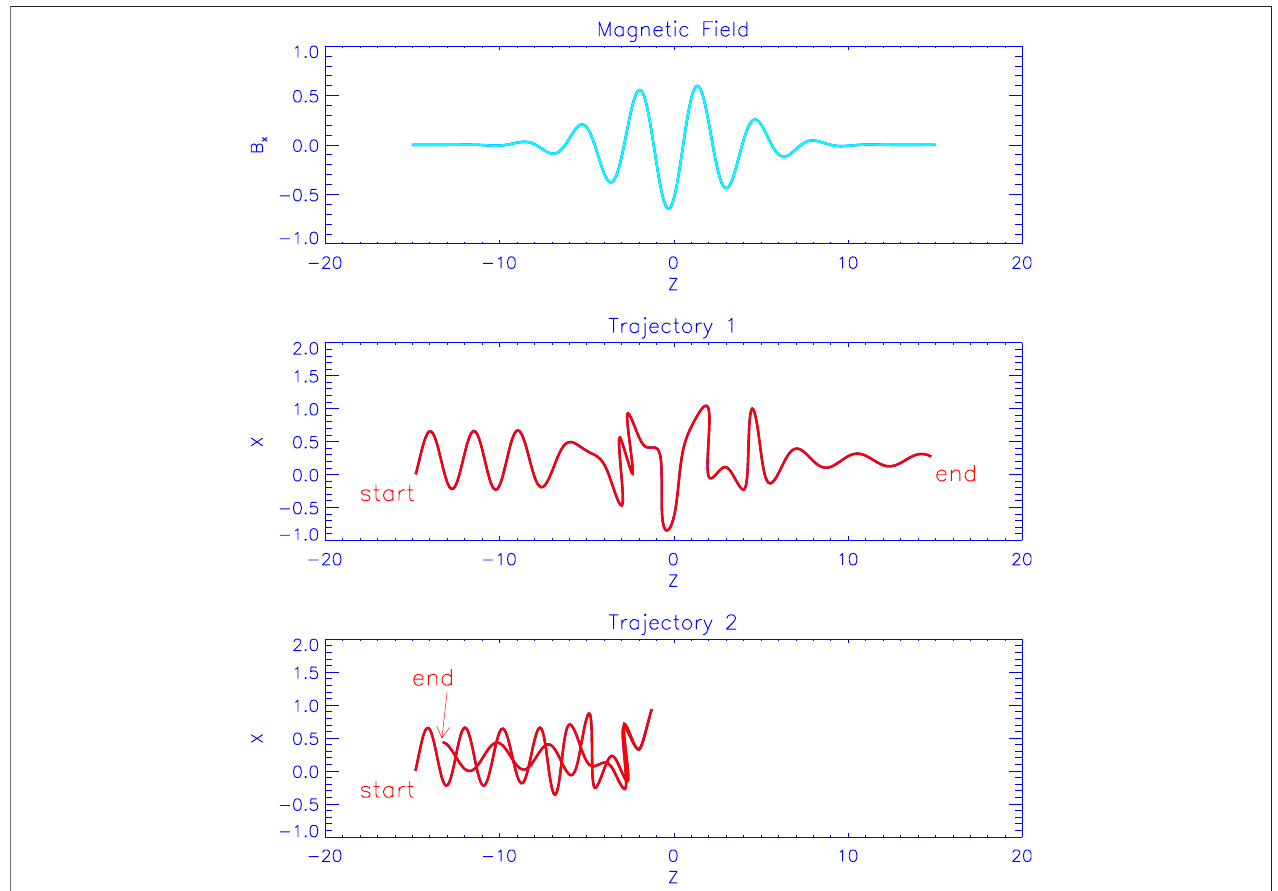
FIGURE 1 | Computed orbits of two particles in a speci fi ed magnetic fi eld that is axisymmetric along the z axis. The two particles are started with nearly the same initial velocity and position, but behave quite differently. This sensitivity to initial conditions results in chaotic or random trajectories (Buechner and Zelenyi, 1989; Xie and Liu,